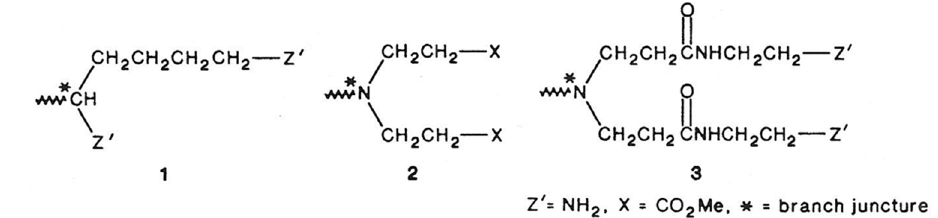
Figure 2. Branch cell ( 1 ); asymmetrical unequal segmented Denkewalter-type poly(L-lysine) (PL) dendrimers. Branch cells ( 2 ) and ( 3 ) symmetrical, equal segmented Tomalia-type poly(amidoamine) (PAMAM) dendrimers. Reprinted with permission from [28]. Copyright 1987 American Chemical Society.